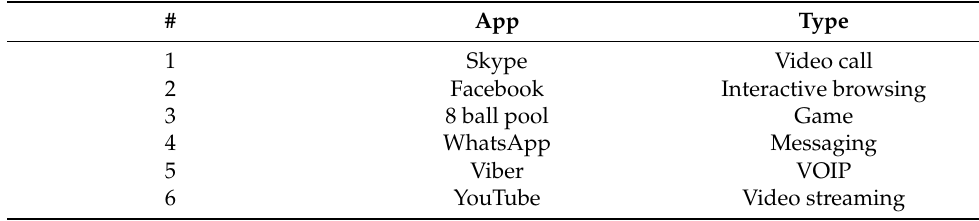
Table 2. Experiment data set